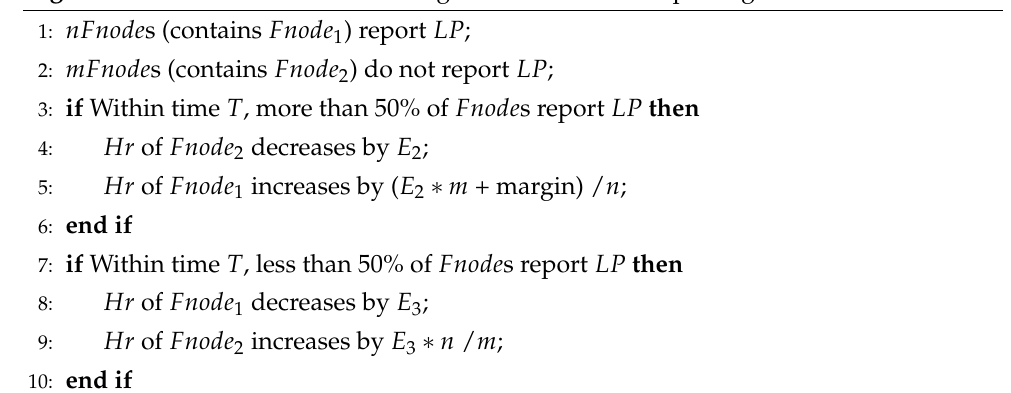
Algorithm 6 Pseudocode for the change in Fnode ’s Hr in reporting LP .